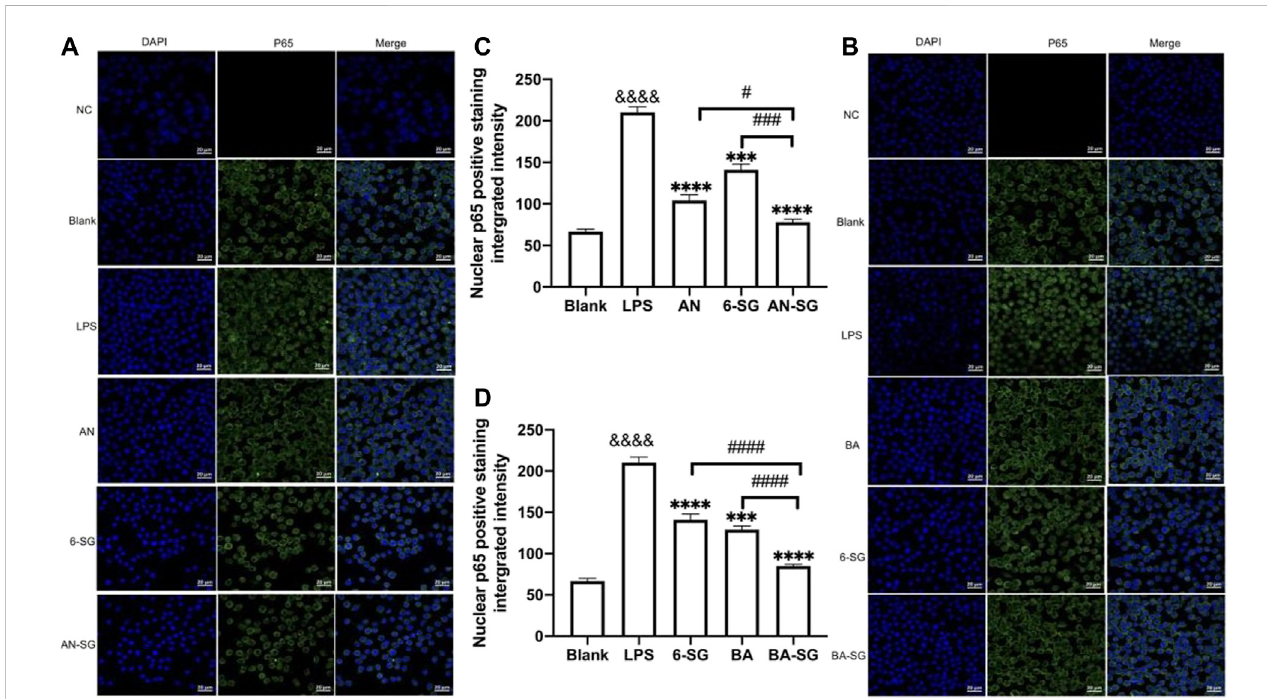
FIGURE 5 AN-SG and BA-SG exhibited greater effects in inhibiting LPS-induced NF- κ B nuclear translocation than the individual component in the N11 cells of the tri-culture model. (A) AN-SG and (B) BA-SG for the immuno fl uorescence staining of NF- κ B p65. Images were taken using a confocal microscope with × 63 magni fi cation. Blue: DAPI in the nucleus, green: NF- κ B p65 in the N11 cells. Scale bar = 20 μ m. (C, D) Statistical analysis of the NF- κ B p65 translocation activitiesbyAN-SGandBA-SGusingImageJ.Dataareshownasmean±SEM( n > 3).&&&& p < 0.0001vs.Blank,*** p < 0.001,**** p < 0.0001vs.LPS,# p